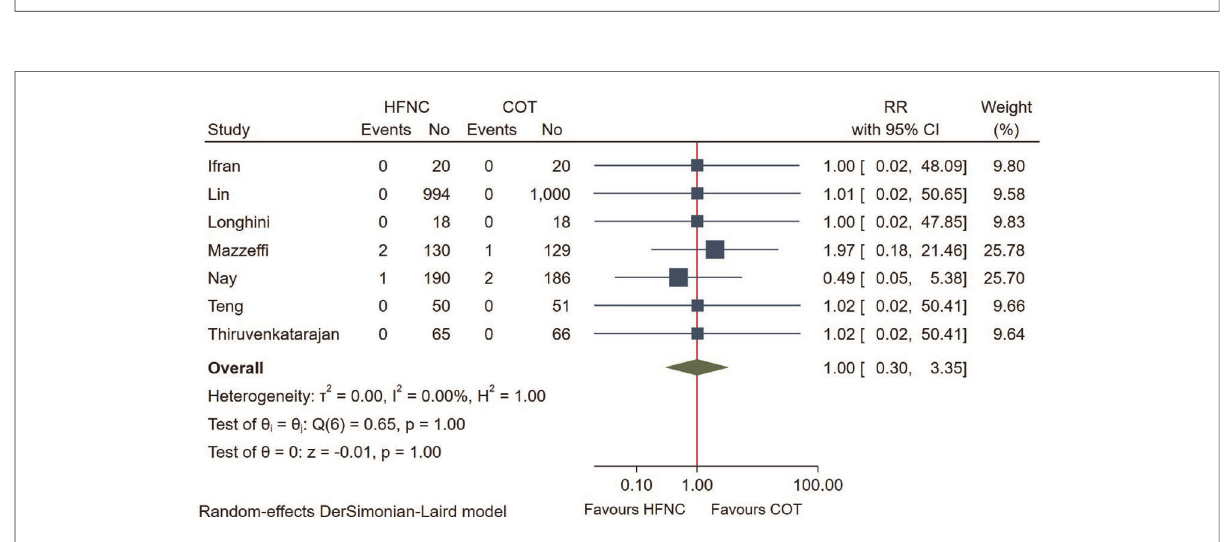
FIGURE 7 Forest plot comparing incidence of intubation after the procedure in HFNC versus COT. HFNC, high fl ow nasal cannula; COT, conventional oxygen therapy; RR, risk